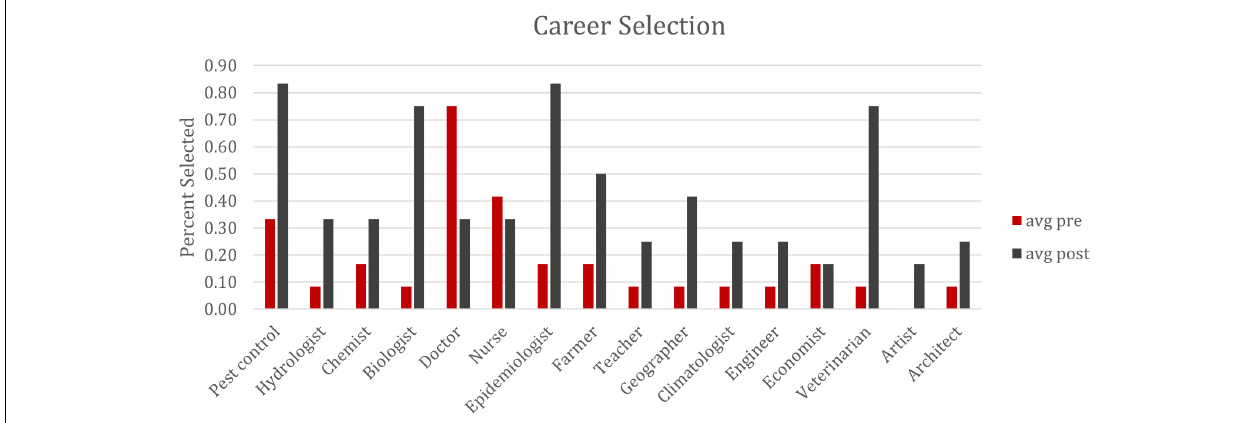
FIGURE 2 | Percentage of careers selected both pre and